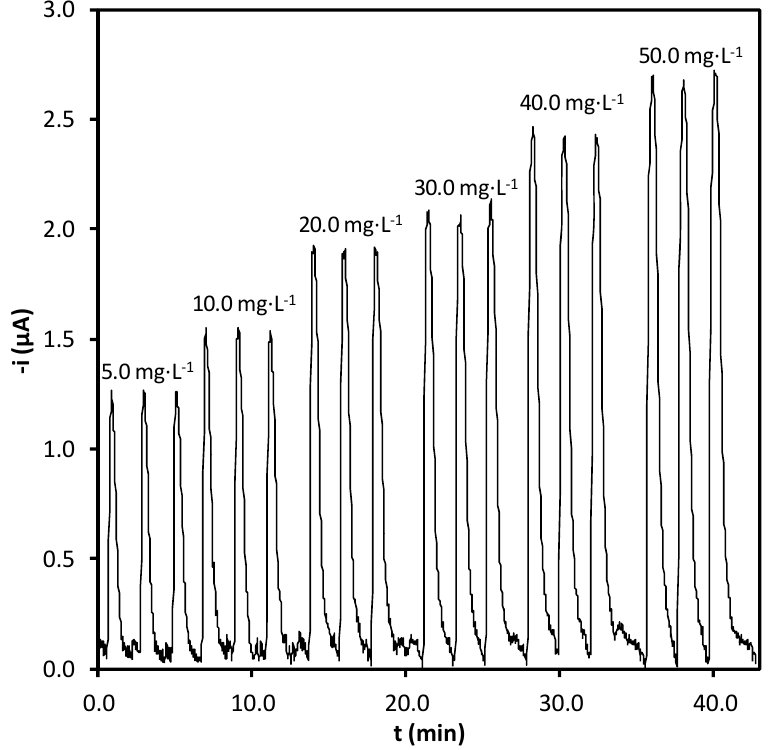
Figure 4. Recorder output obtained with the proposed system, providing an oxalate calibration plot between 5.0 and 50.0 mg·L − 1 .